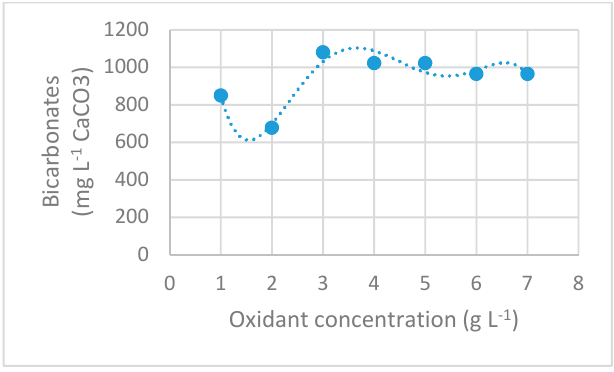
Figure 5. Effect of hydrogen peroxide oxidation on the concentration of